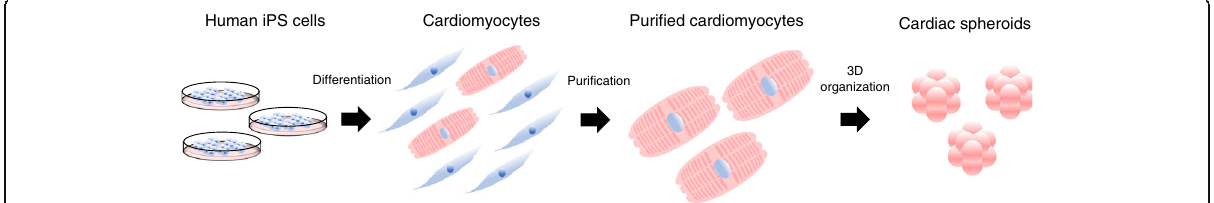
Fig. 1 Strategy of cardiac regenerative therapy using human iPSC-derived cardiomyocytes. iPSC, induced pluripotent stem cell